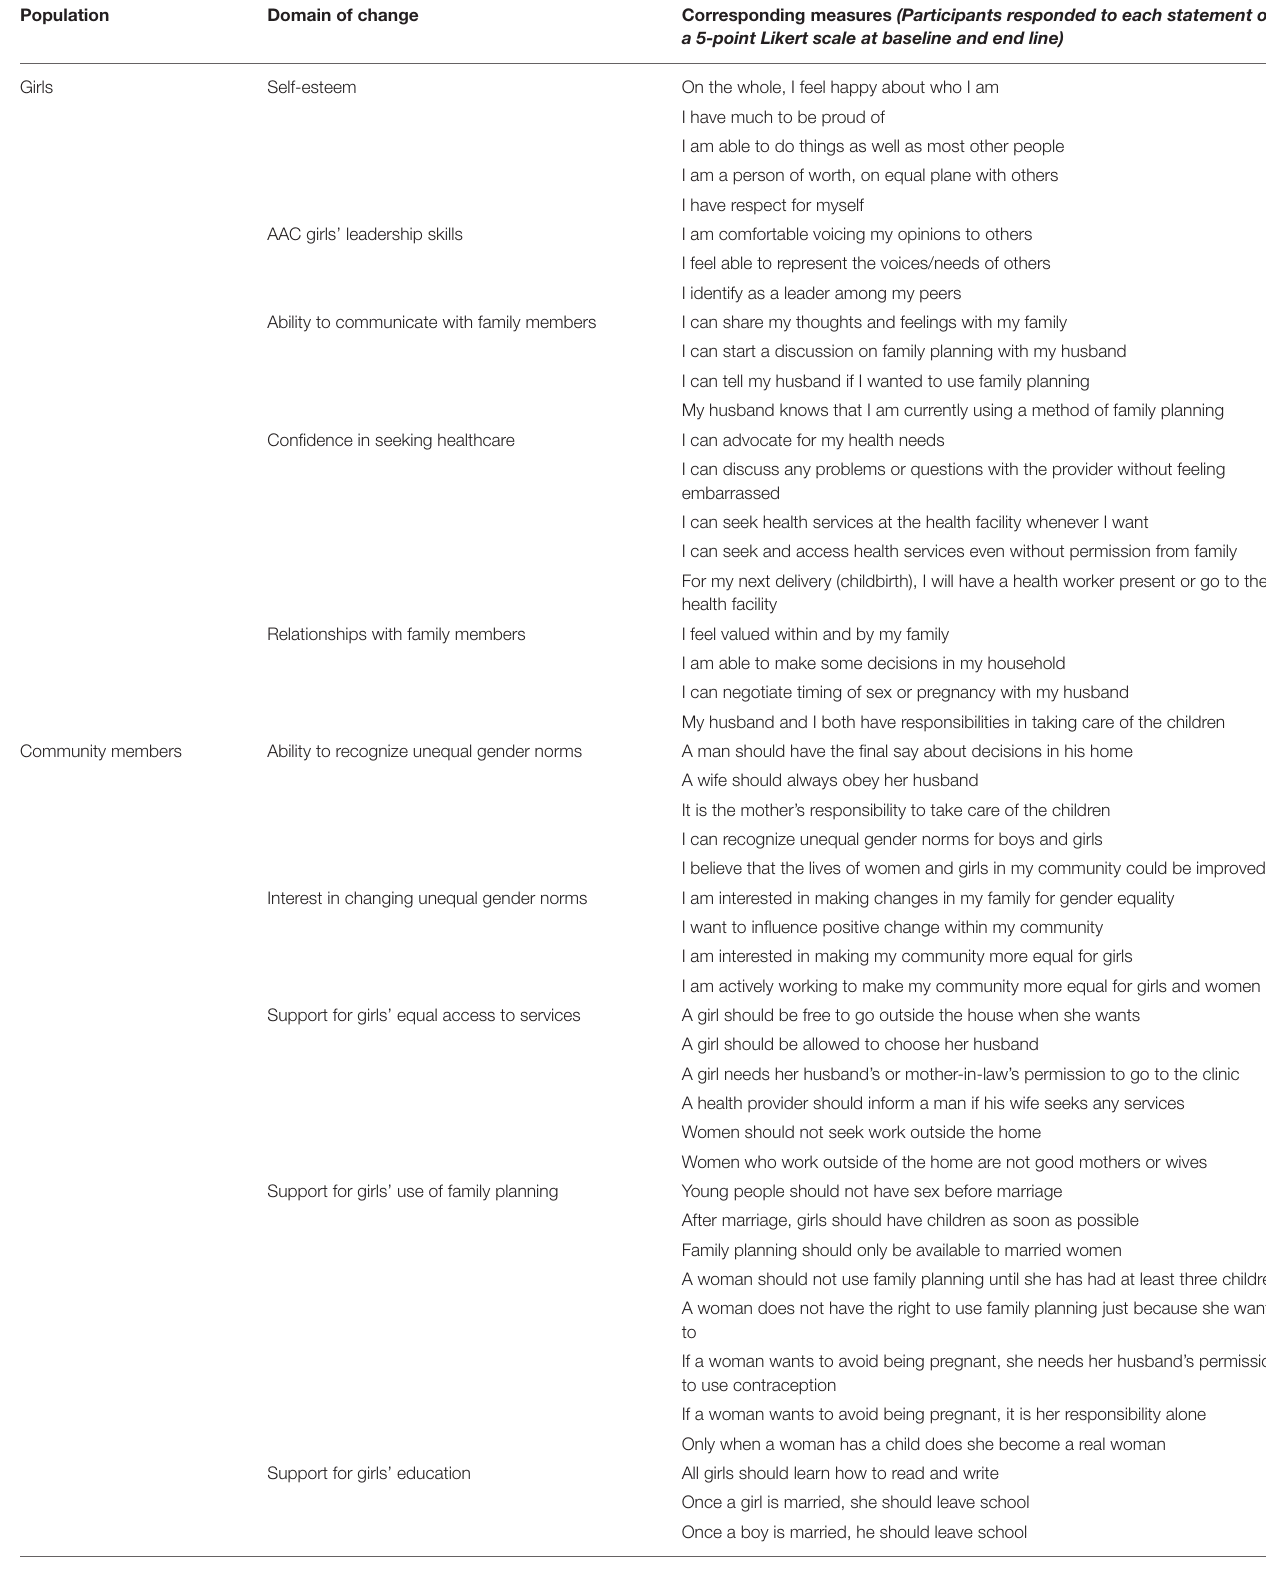
TABLE 1 | Survey measures corresponding to each domain of change for each target population.